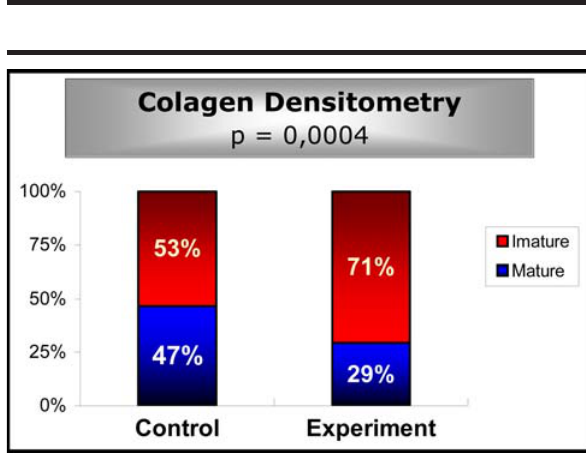
FIGURE 4 - Predominance of Immature collagen in experiment